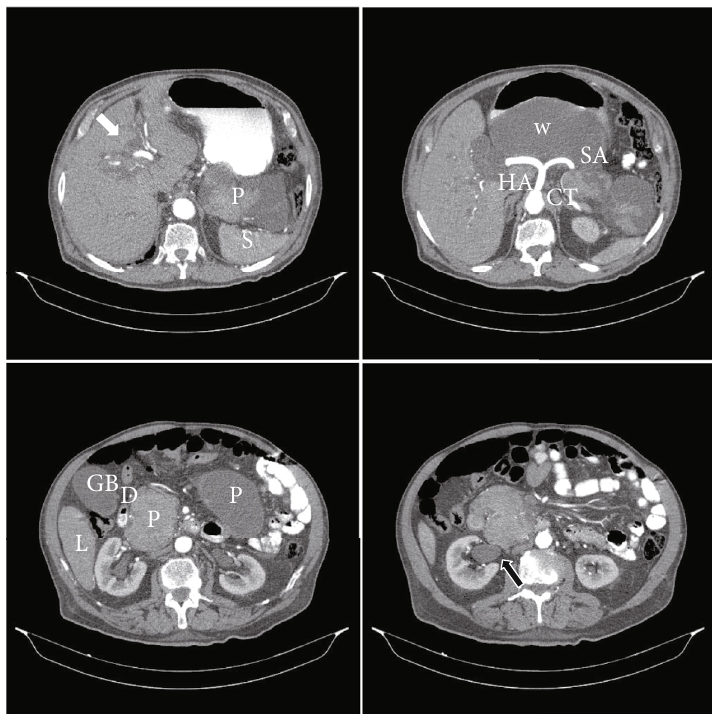
Figure 1: Preoperative CT scan. White arrow: biliary tree dilatation, Black arrow: right hydronephrosis. CT: celiac trunk; D: duodenum; GB: gallbladder; HA: hepatic artery; L: liver; P: pancreas; S: spleen; SA: splenic artery; W: Wirsung duct.